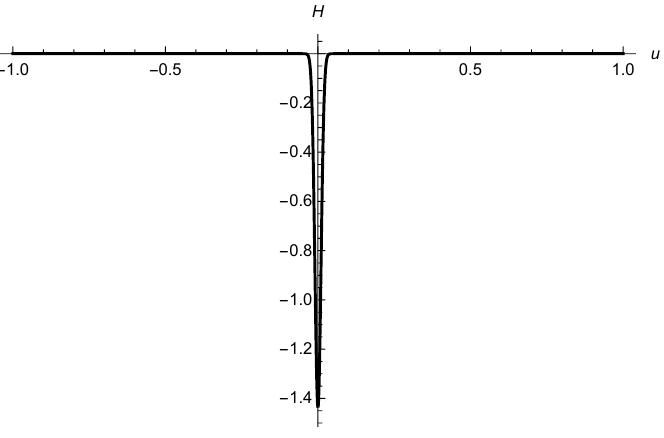
Figure 14. H 3 ( u ) when λ =